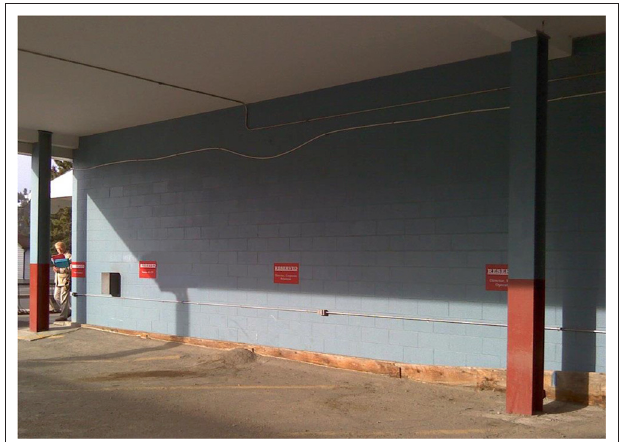
FIGURE 4 | The second layer of XPS is shown in place over 6mm polyurethane foam. The XPS layer ensured that the bottom surface of each VIP was attached to a smooth surface and protected from abrasion. A layer of 6mm flexible polyurethane foam was placed over the exterior surface of the VIPs to help prevent mechanical rubbing of the outside surface of each VIP against the 25mm polystyrene foam board placed on top of it.